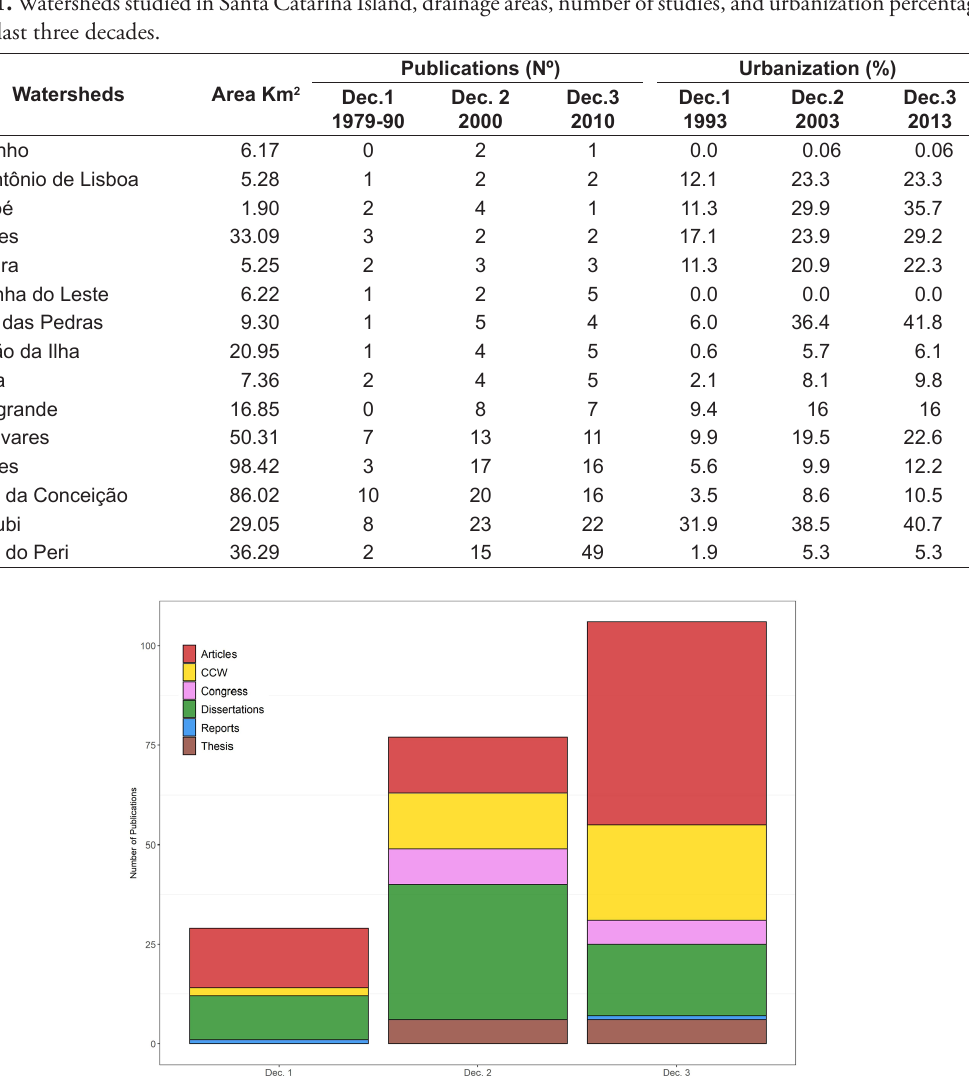
Figure 4. Number (N) of publications in watersheds in Santa Catarina Island separated by document types in the last three decades (Red = articles; Brown = doctoral thesis; Green = master’s dissertation; Yellow = completion of course works; Pink = congress abstracts; and Blue = technical